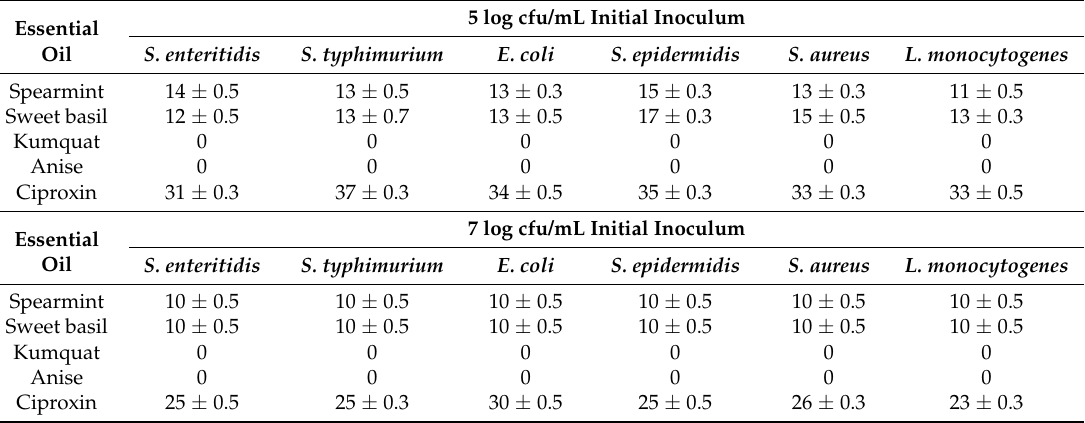
Table 2. Antibacterial activity of the essential oils against common food spoilage and pathogenic bacteria monitored by the disk diffusion assay. Ciproxin was used as positive control.